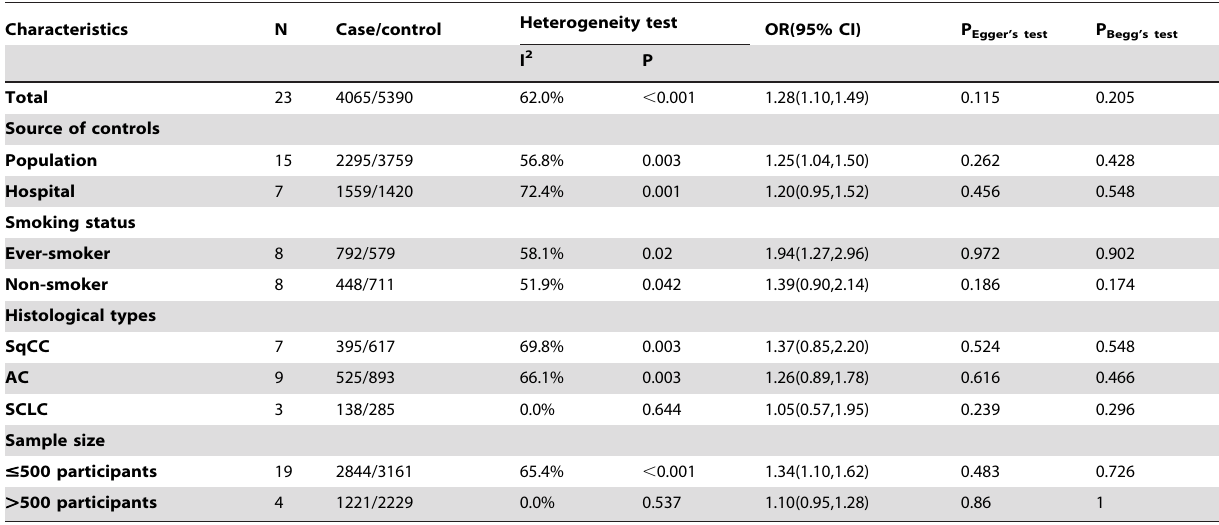
Table 2. Meta-analysis Results.